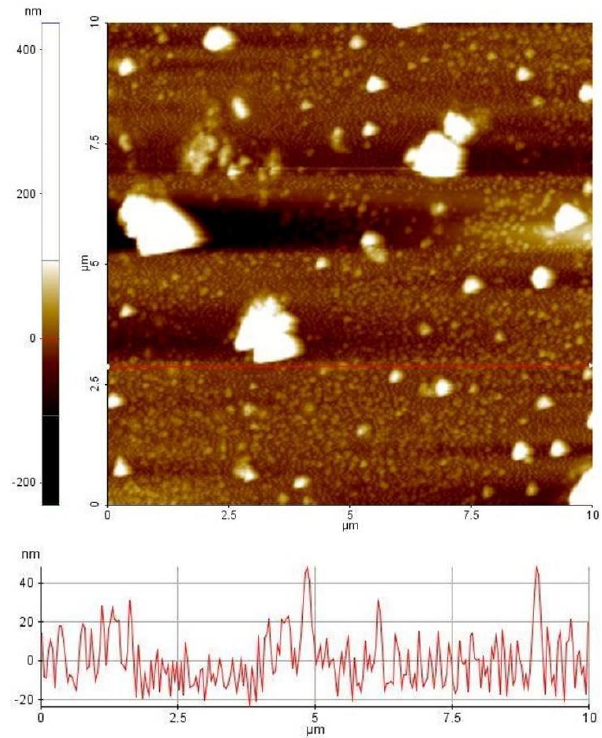
Figure 5. AFM image and line profile of GNPs.